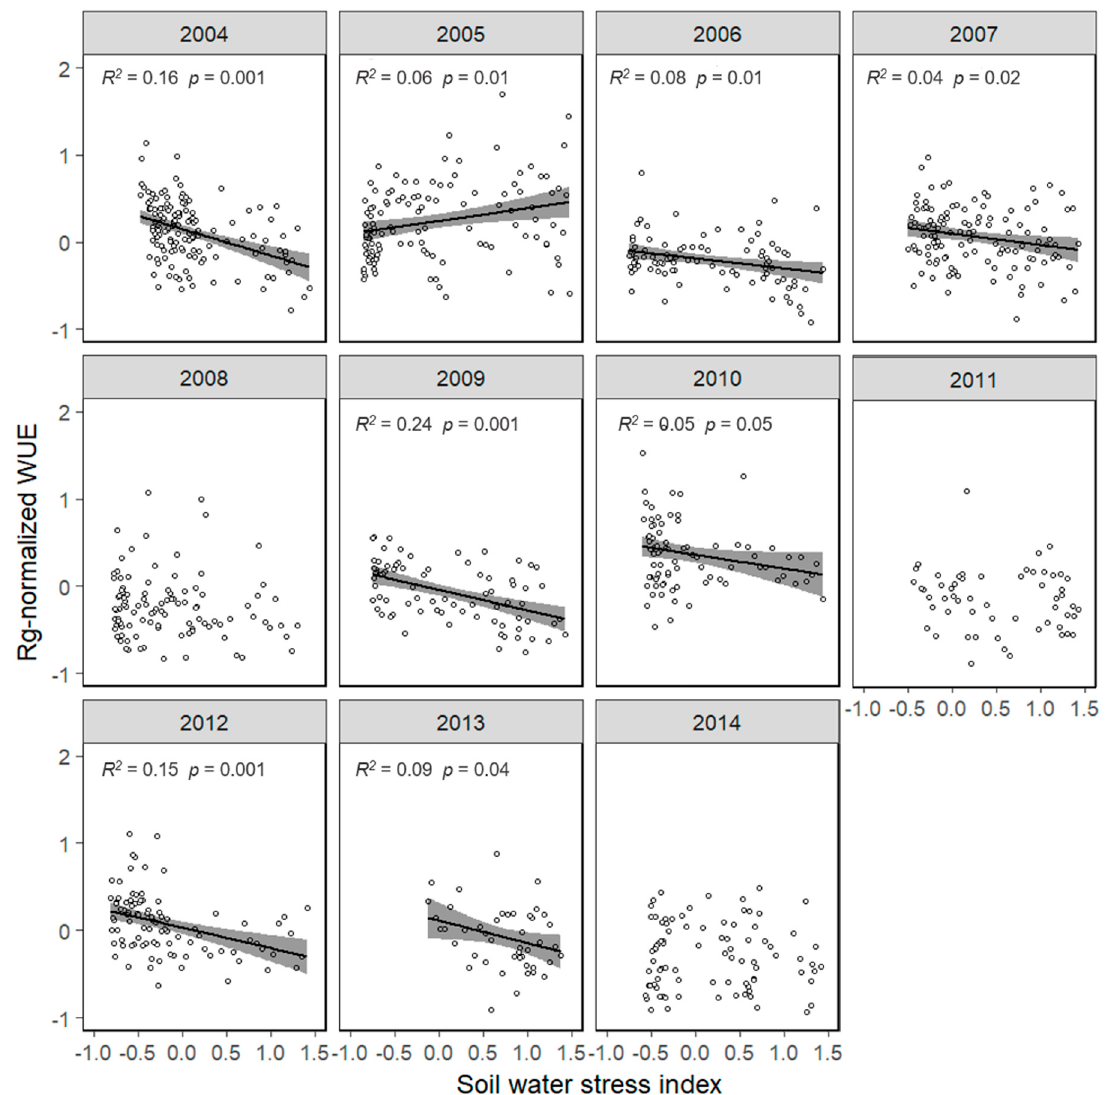
Figure 6. Linear relationship between radiation-normalized water use efficiency (WUE) and the soil water stress index (SWSI) during the water depletion period (WD). Gray-shaded regions are the confidence intervals and the black line in between is the linear trend. Each dot corresponds to one day. The greater the SWSI, the lower the soil water stress.